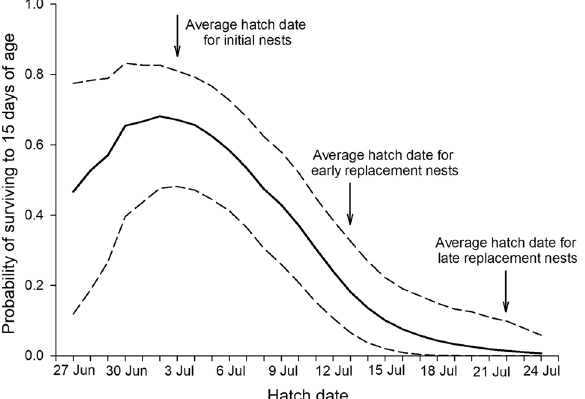
Figure 5. Estimated probability of a Dunlin chick surviving to 15 days of age near Utqiaġvik, Alaska, 2008– 2009 as a function of hatch date (solid line; 95% CI shown as dashed lines). Survival probabilities and associated CIs were estimated using average invertebrate biomass estimates based on date and 10,000 simulations of the beta estimates assuming a multivariate normal distribution and the variance–covariance matrix from the top- ranked model (HD*A 2 + I; where HD = hatch date, A = chick age, and I = daily invertebrate biomass; Table